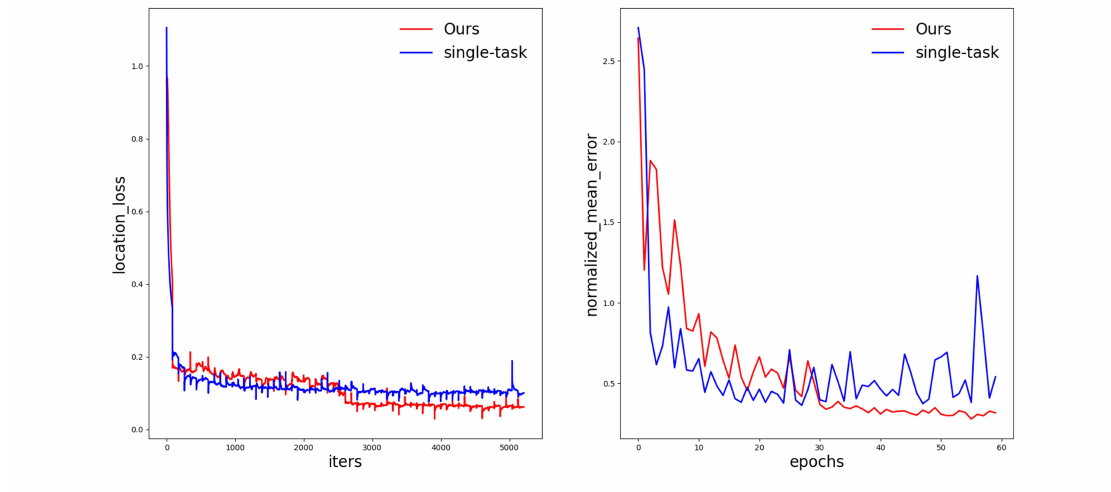
Figure 13. Location loss and normalized mean error (NME) of our model compared with the single-task network